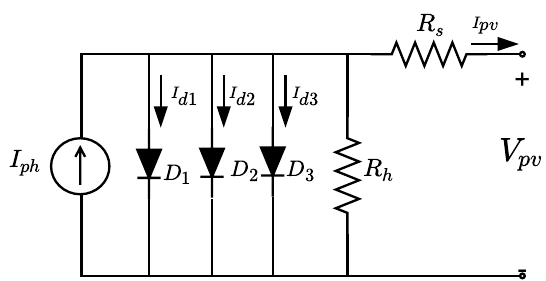
Figure 1. Diagram of the equivalent circuit of a PV panel with three diodes (TDM). The current of the PV panel is mathematically modeled in Equation (1), where I pv denotes the current provided by the PV panel, i.e., the variable to minimize; I d 1 , I d 2 ,